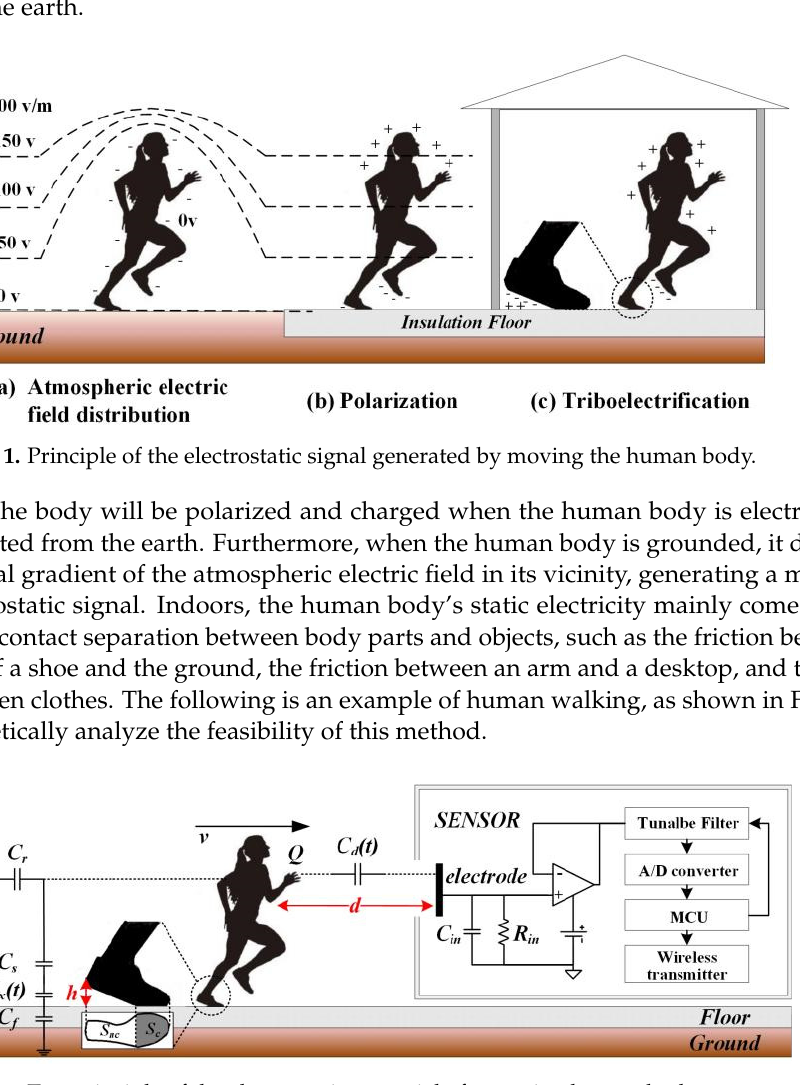
Figure 2. Test principle of the electrostatic potential of a moving human body. As shown in Figure 2, the human body is an electrostatic conductor. There are two high-resistance layers between the body and the ground: the sole (usually rubber, EVA composite material, etc.) and the floor (wooden floor, tile, etc.). Therefore, the overall equivalent capacitance of the human body to the earth C B